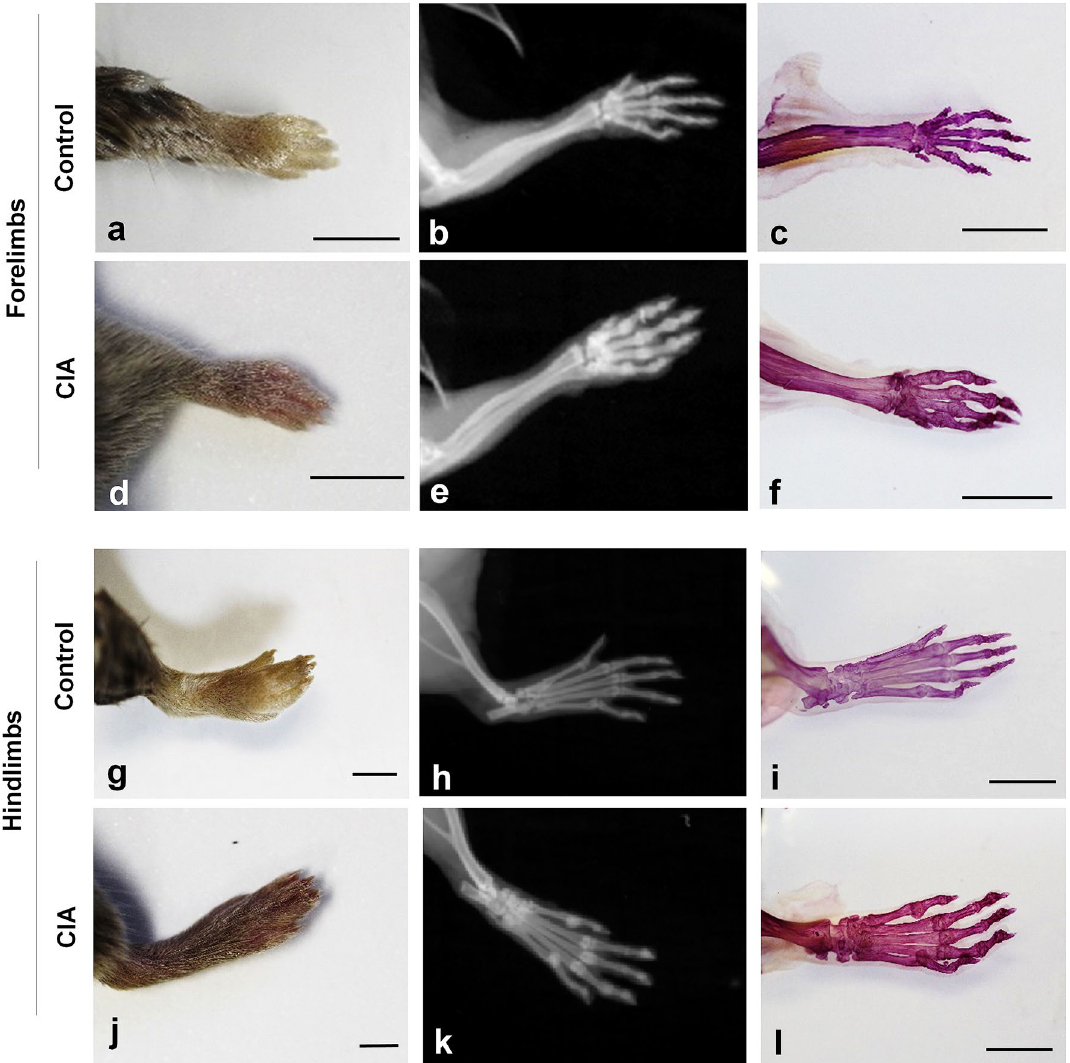
Figure 4. RAP-B modified with hair removal (RAP-B/HR) application examined in CIA mice. The bone and joint pathological changes in CIA mice were not detected by external observation ( a , d , g , and j ). Swelling joints were observed in living mice X-ray images, which were not found in the extremities of a control mouse ( e and k vs. b and h , respectively). Additional detailed changes in bone and joints could be observed in specimens treated with RAP-B/HR. ( c , f , i , and l ). The arthritic mouse joints were swollen. Scale bars: 5